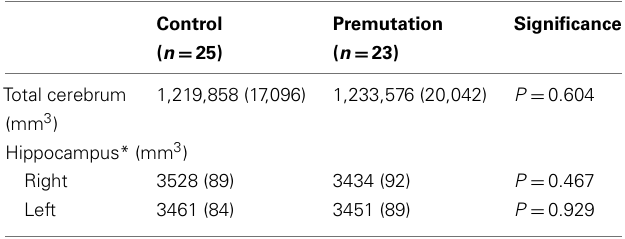
Table 2 | Descriptive statistics for total cerebral and hippocampus volumes by group.